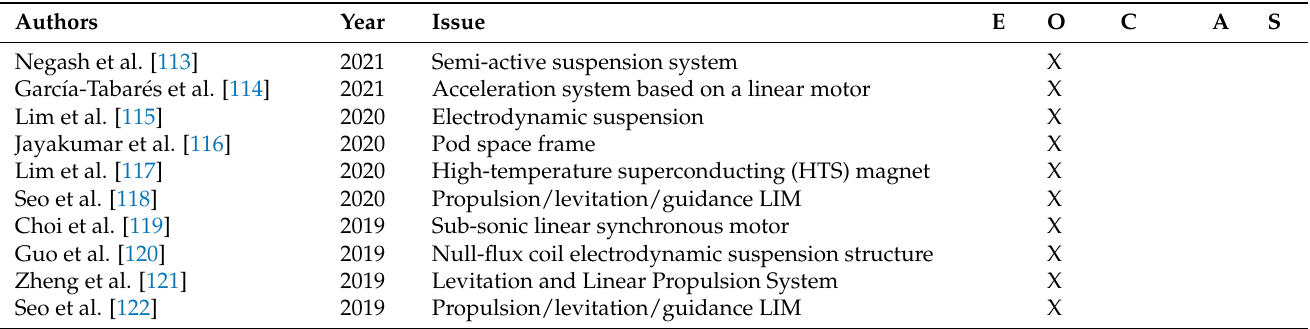
Table 5. Issues identified in research on Hyperloop